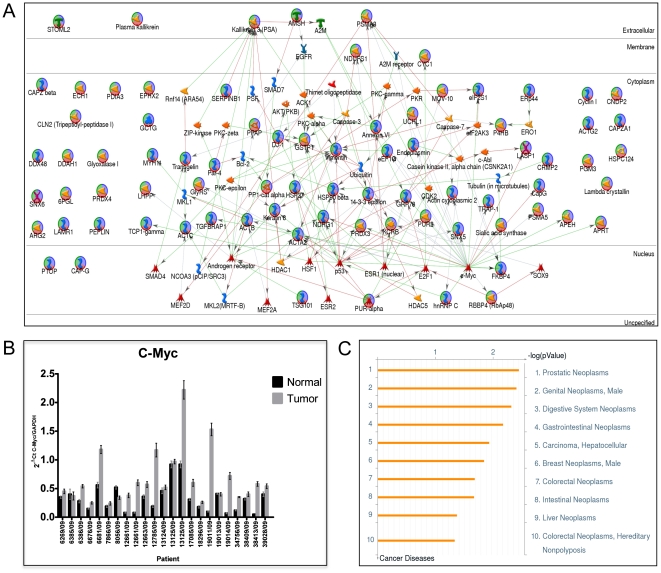
Protein network of differentially expressed proteins in PCa.(A) GeneGO MetaCore™ was used to generate a network of direct connections between all identified proteins with altered expression. Red, green, and gray arrows indicate negative, positive, and unspecified effects, respectively. Many of the identified proteins mapped to AR, p53 and c-Myc pathways involved in PCa progression where as some proteins were not connected in network. (B) To validate major hubs of the network c-Myc expression at transcriptional level assed by real time PCR from an independent set of samples. Results showed significant increase in the amount of c-Myc mRNA suggests it may have direct/indirect regulation of its connected proteins of shortest network. (C) Enrichment of GeneGo diseases by topologically significant proteins identified using all differentially expressed proteins. Data represents differentially expressed proteins mapped to prostatic neoplasms with highest significance followed by male genital neoplasms.